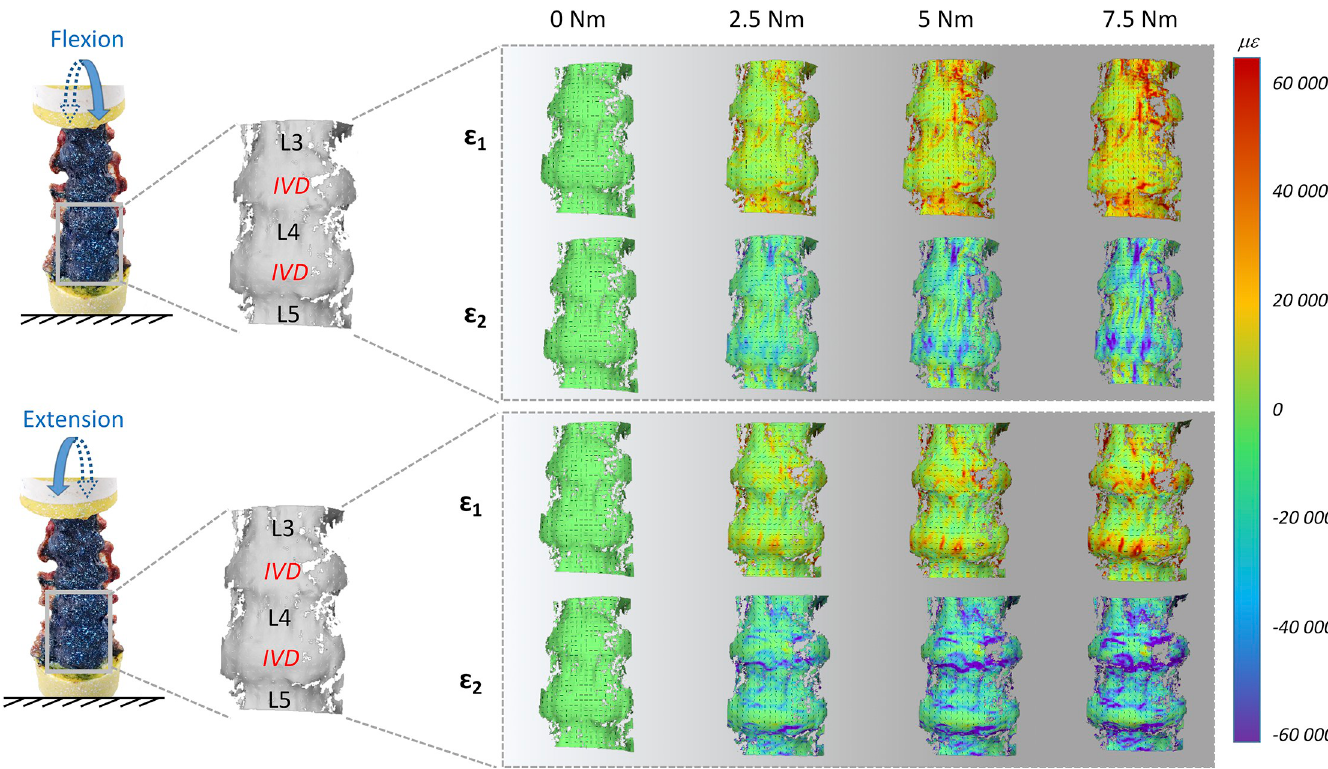
Fig 2. Flexion and extension: Maximum (eps 1 ) and minimum (eps 2 ) principal strain fields during the progression of the loading cycle (0.0, 2.5, 5.0, 7.5 Nm) in both opposite directions. The images on the left show the actual specimen under load and the correlated (the vertebrae and IVDs are labelled). The false-colours maps show the non-uniform distribution of strain. The black dashes indicate the principal strain directions. A typical specimen (#2) is shown here. Similar patterns were observed in all 5 specimens (the strain maps for all the individual specimens are reported in the S1 Fig, S1 and S2 Dataset). A movie of the entire loading cycle is available on https://doi.org/10.6084/m9.figshare.11397951.